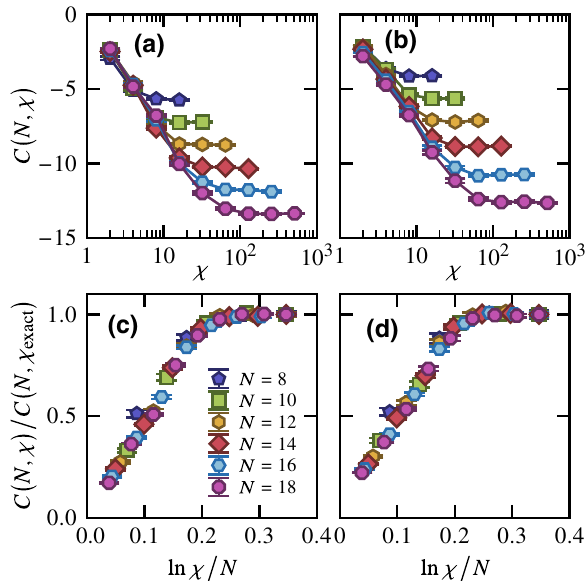
FIG. 2. Left column: 3-regular graphs with unit weight and QAOA depth p = 2. Right column: complete graphs with uni- form random weight w ij ∈ [0, 1] and QAOA depth p = 4. Top row: the cost versus the bond dimension χ for different sizes N . Bottom row: the same data as the top row but with the Y axis divided by the cost at χ exact = 2 N / 2 and the X axis changed to ln χ/ N . The data collapse onto a single curve Y = F ( X ) , reveal- ing a scaling law. Note the deviation for the smallest size N = 8 from the